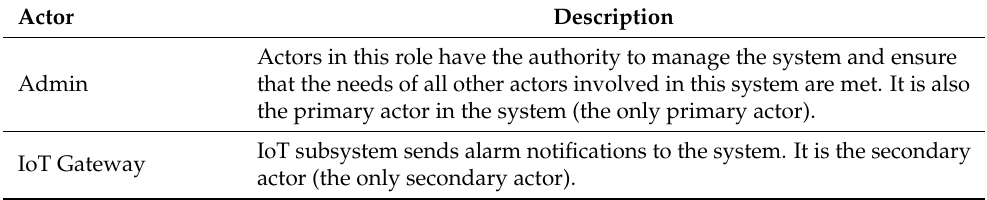
Table 1. Descriptions of the actors in the proposed system.